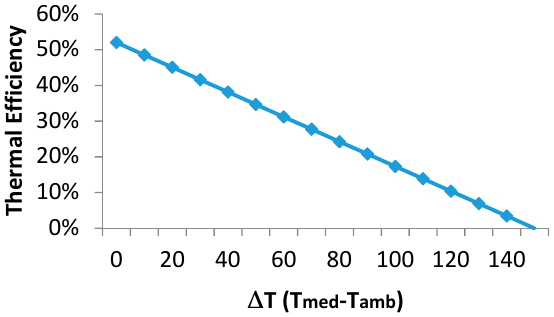
Figure 5. Thermal e ffi ciency curve of the prototype Figure 5. Thermal efficiency curve of the prototype collector. Figure 5. Thermal efficiency curve of the prototype collector.